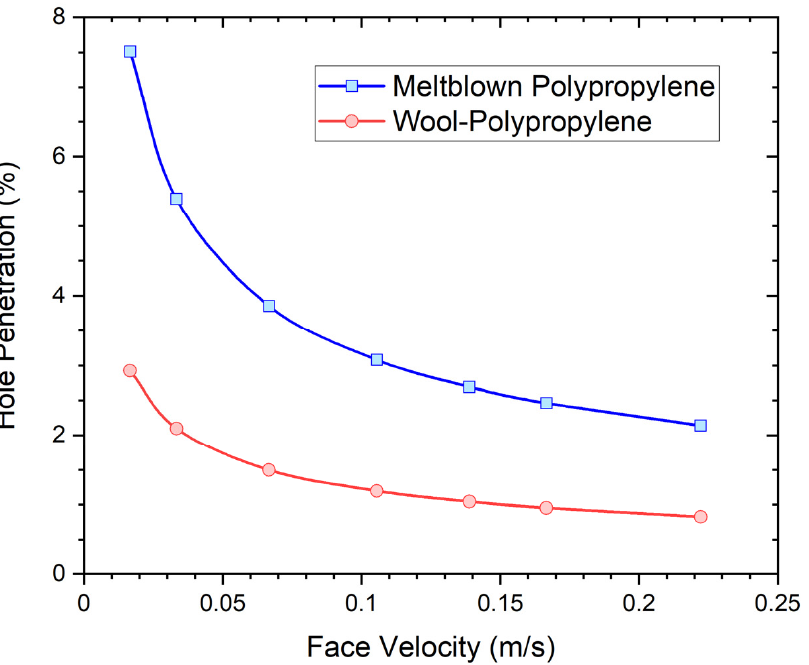
Figure 3. Modelled respirator leakage rates (hole penetration) as a function of face velocity for wool/polypropylene and melt blown polypropylene filter media with pressure drops of 30 Pa and 200 Pa at a face velocity of 0.15 m/s. Trendlines (modified Bézier) have been added for illustration purposes to calculated data represented by dots.